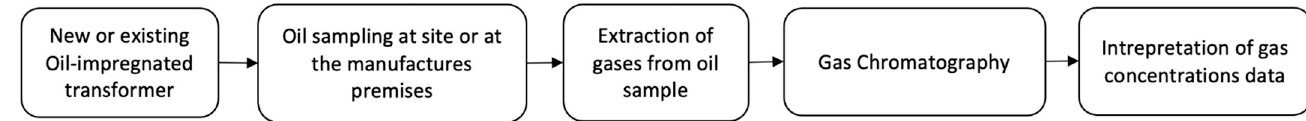
Figure 1. Extraction of transformer oil in the field for DGA.